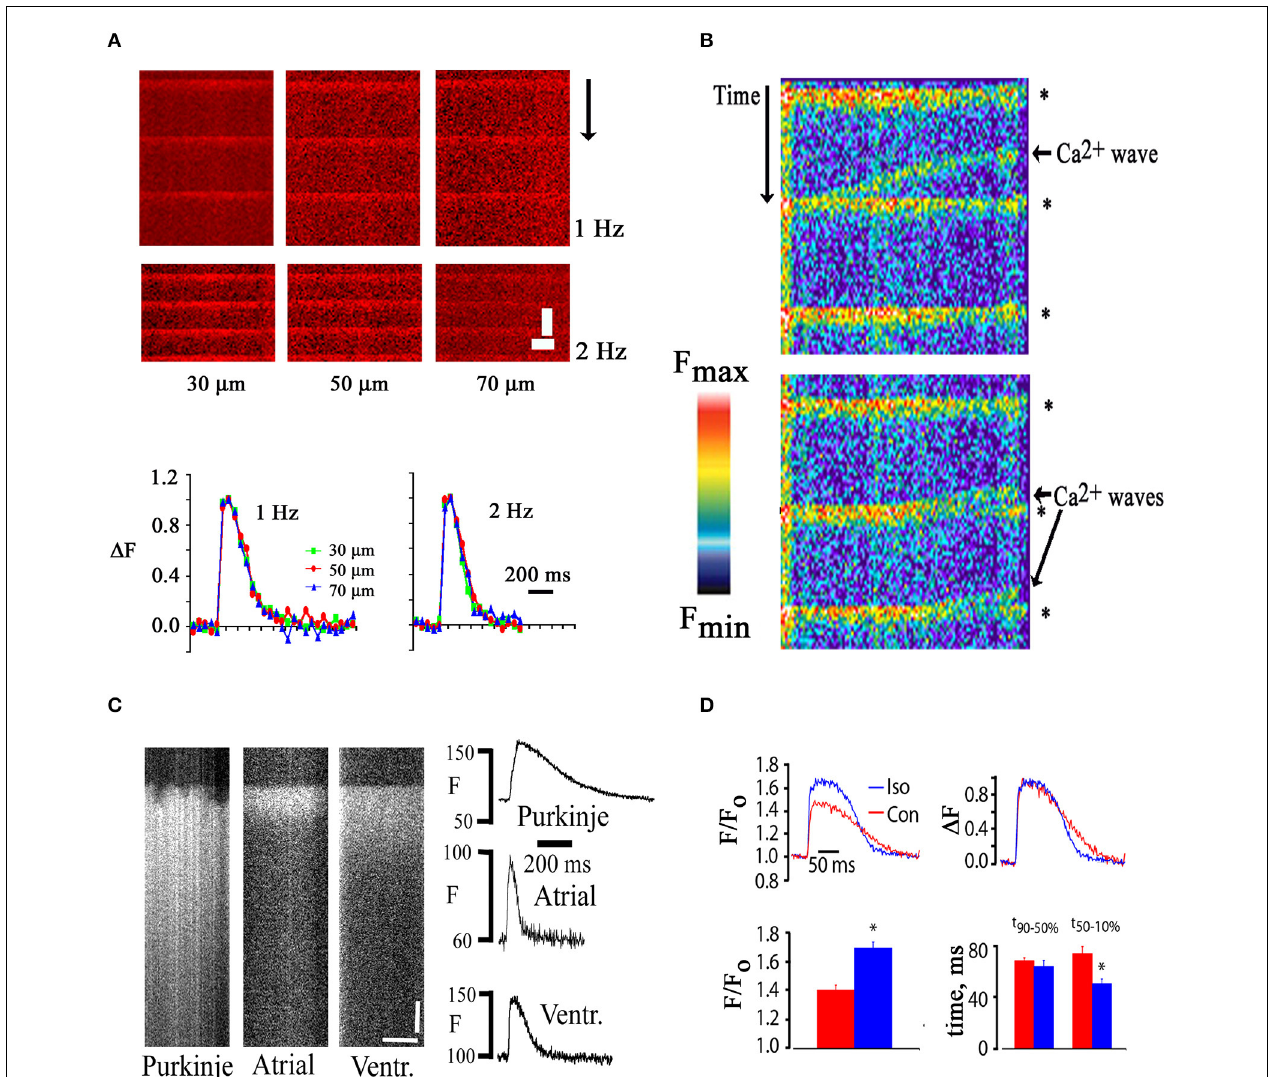
caused annihilation of the waves. (C) Line-scan images of electrically evoked rhod-2 transients of a right ventricular endocardial Purkinje myocyte, a left atrial myocyte, and a left ventricular mycoyte in Langendorff-perfused mouse hearts. Plots of spatially averaged rhod-2 transients as a function of time for each cell type are shown on the right. Scale bars, 50ms vertically, 10 μ m horizontally. (D) Changes in [Ca 2 + ] i transient amplitude and duration following exposure of a rhod-2–loaded, isolated perfused mouse heart to isoproterenol (100nmol/L) in the presence of cytochalasin D (50 μ mol/L). Bar graphs show mean changes in peak F/F o (lower left panel) and in the time course of fluorescence recovery (lower right panel). With permission from the American Physiological